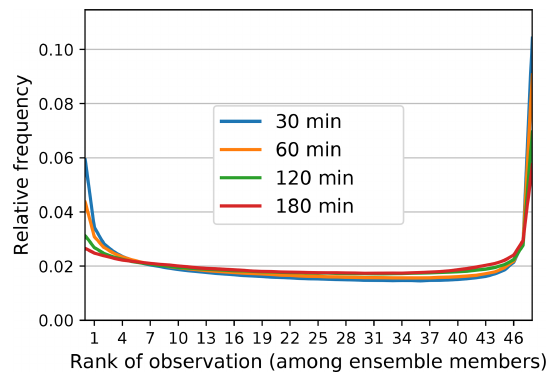
Figure 7. Rank histograms computed from STEPS nowcasts during the MeteoSwiss events listed in Table 8 with different lead times. The default settings listed in Table 5 were used for computing the nowcasts.